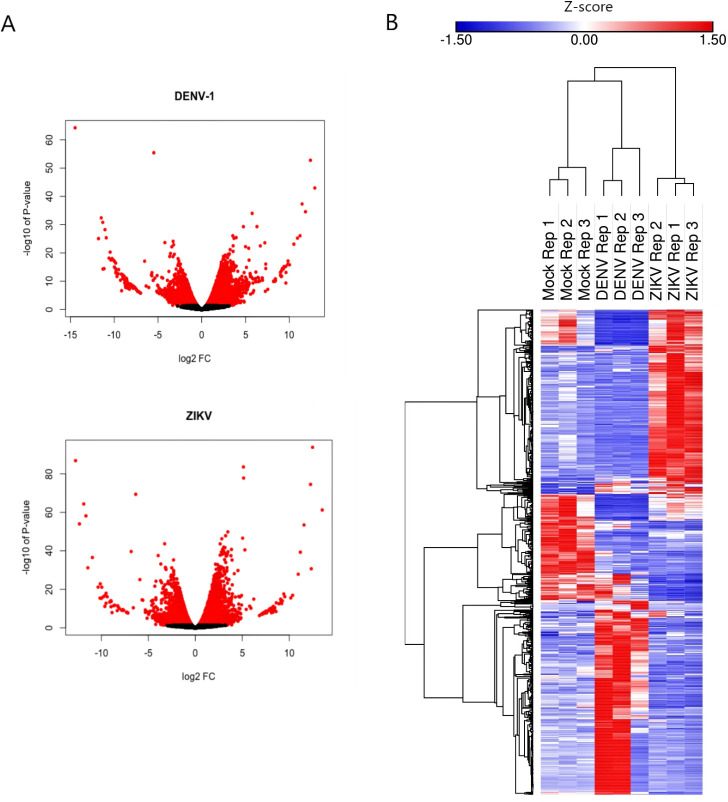
lncRNA expression profiles of DENV and ZIKV-infected Ae. albopictus cells.A) Volcano plot of differentially expressed Ae. albopictus lncRNAs in DENV-1 and ZIKV-infected C6/36 cells. Dots with red color represent lncRNAs with P-value < 0.05. B) Hierarchical clustering of differentially expressed Ae. albopictus lncRNA was done in Morpheus (https://software.broadinstitute.org/morpheus), using one minus Pearson correlation metric with average linkage method.